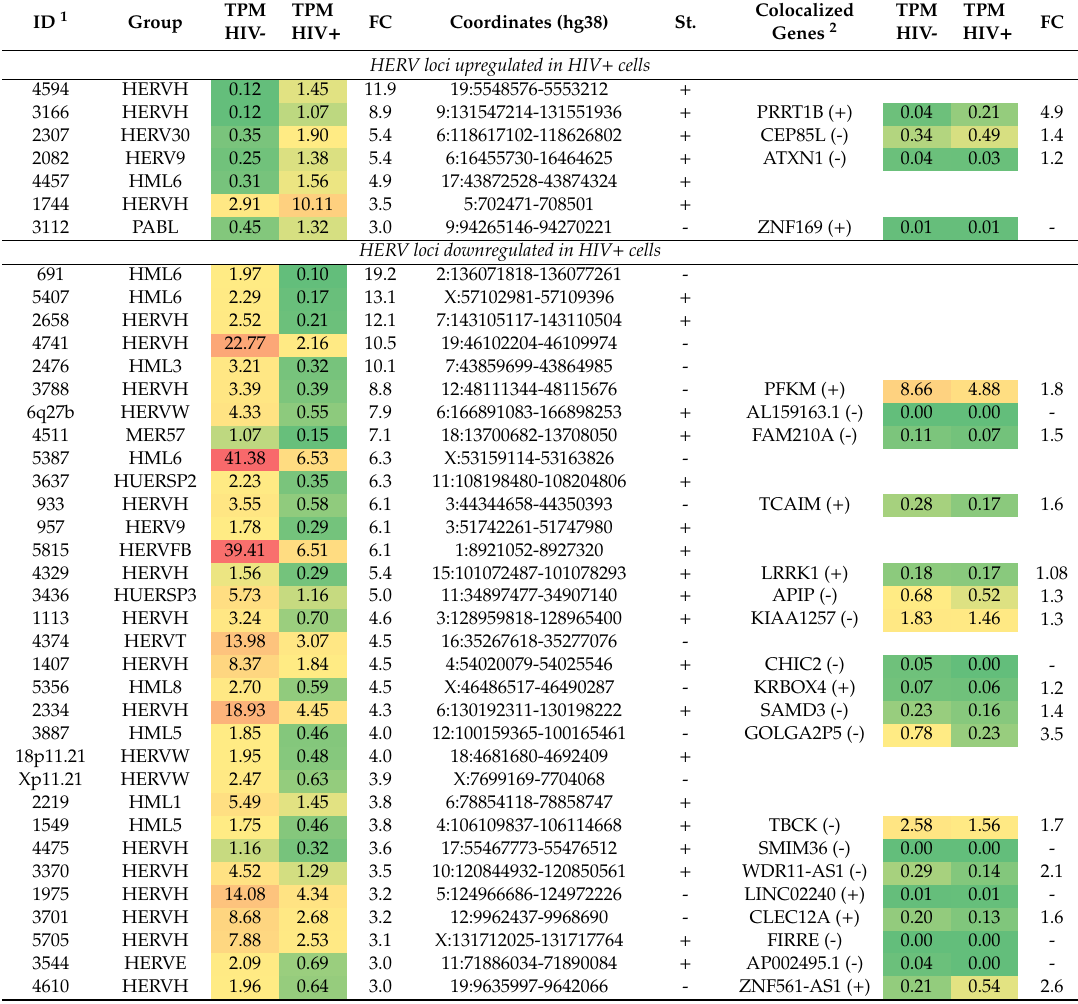
Table 1. Individual HERV loci modulated in the presence of HIV